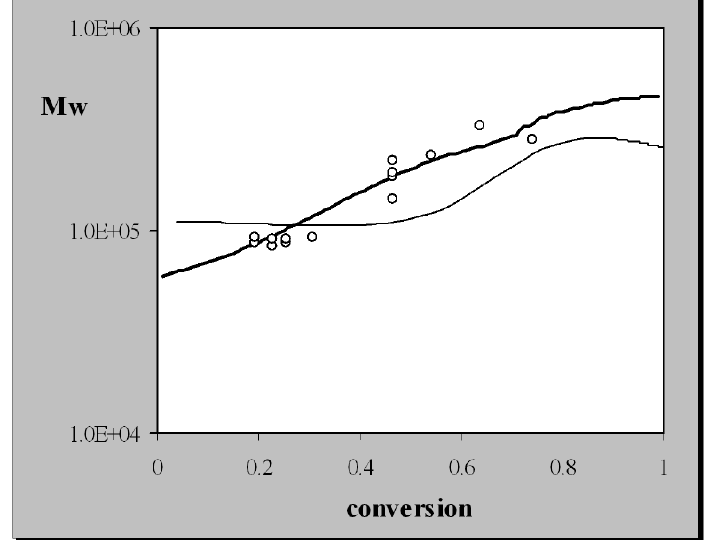
Fig. 12 Weight average molecular weight (logarithmic scale) obtained with MLP (3:10:1) (thick line), by simulation on the kinetic model (thin line) and experimentally (o) [15], [16] at 90 o C and 25.8 mol/m 3